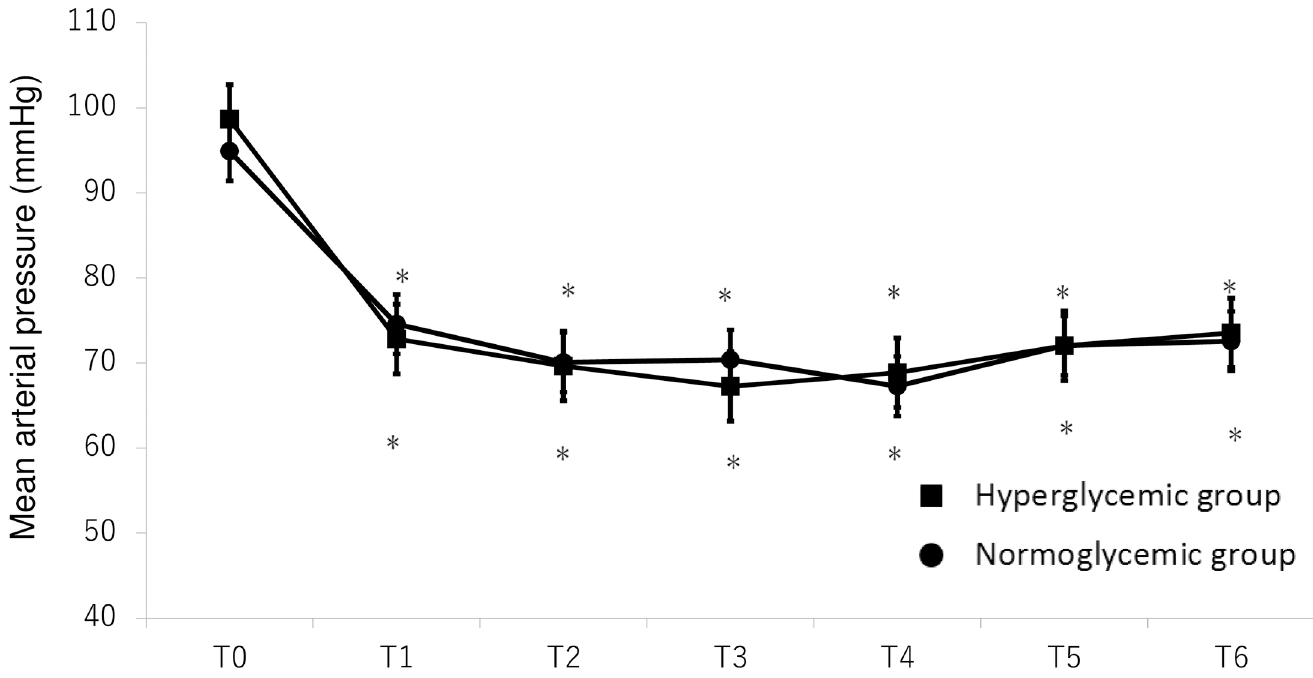
Fig 6. Mean arterial pressure (mean ± SE; mmHg) versus measurement time points before and after sevoflurane administration in the chronically hyperglycemic group (closed squares) and in the normoglycemic group (closed circles). The values recordedbefore the administration of sevoflurane (T0) and at 5 (T1), 10 (T2), 30 (T3), 60 (T4), 90 (T5), and 120 (T6) min after the administration of sevoflurane are shown. * P < 0.05comparedwith the baseline(pre) value.